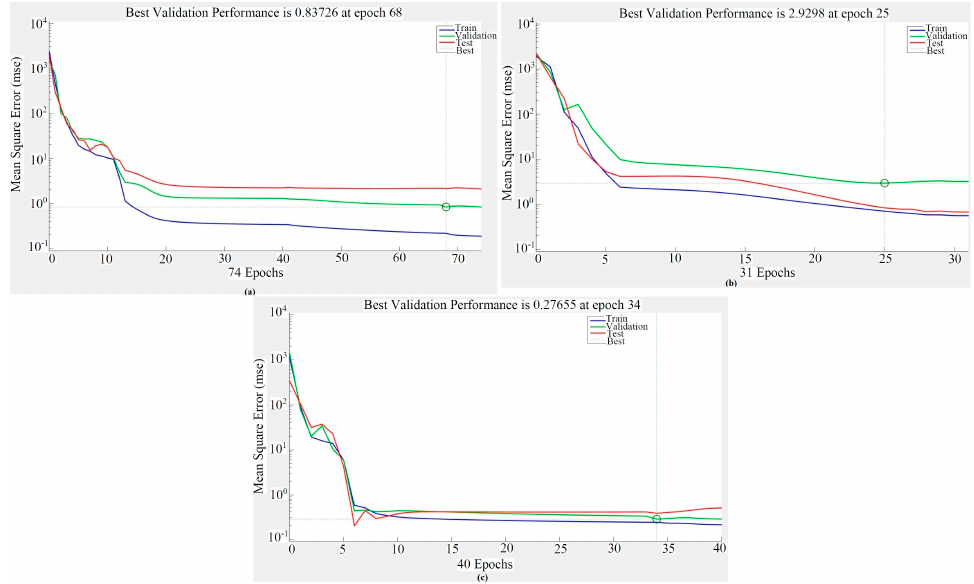
Figure 8. Mean square error (MSE) versus the number of epochs for diclofenac ( a ), ibuprofen ( b ), and naproxen ( c ).